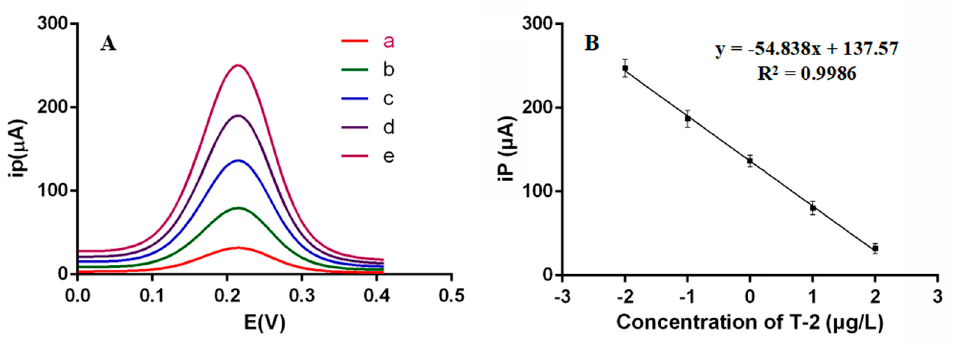
Figure 4. ( A ) DPV peak currents of the electrochemical immunosensor with different T-2 concentration of 0.01, 0.1, 1, 10, 100 µ g · L − 1 (from a – e ). ( B ) Plot of DPV peak currents vs. Different T-2 concentrations. The error bars represented standard deviation for three measurements.